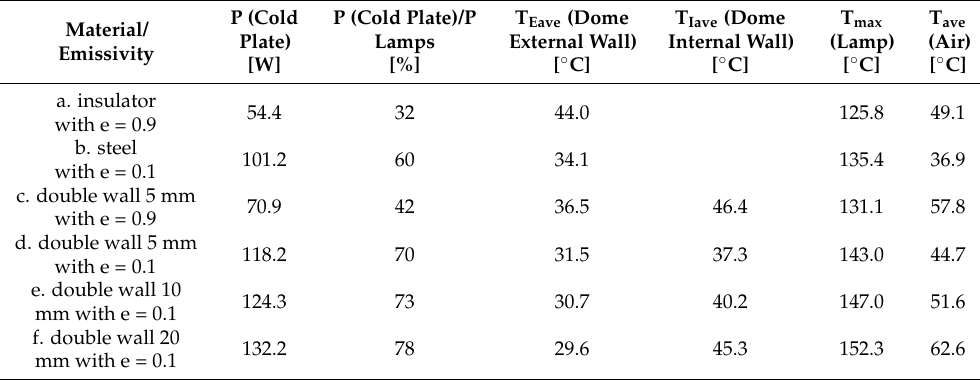
Table 2. Results of simulations for the different dome designs.